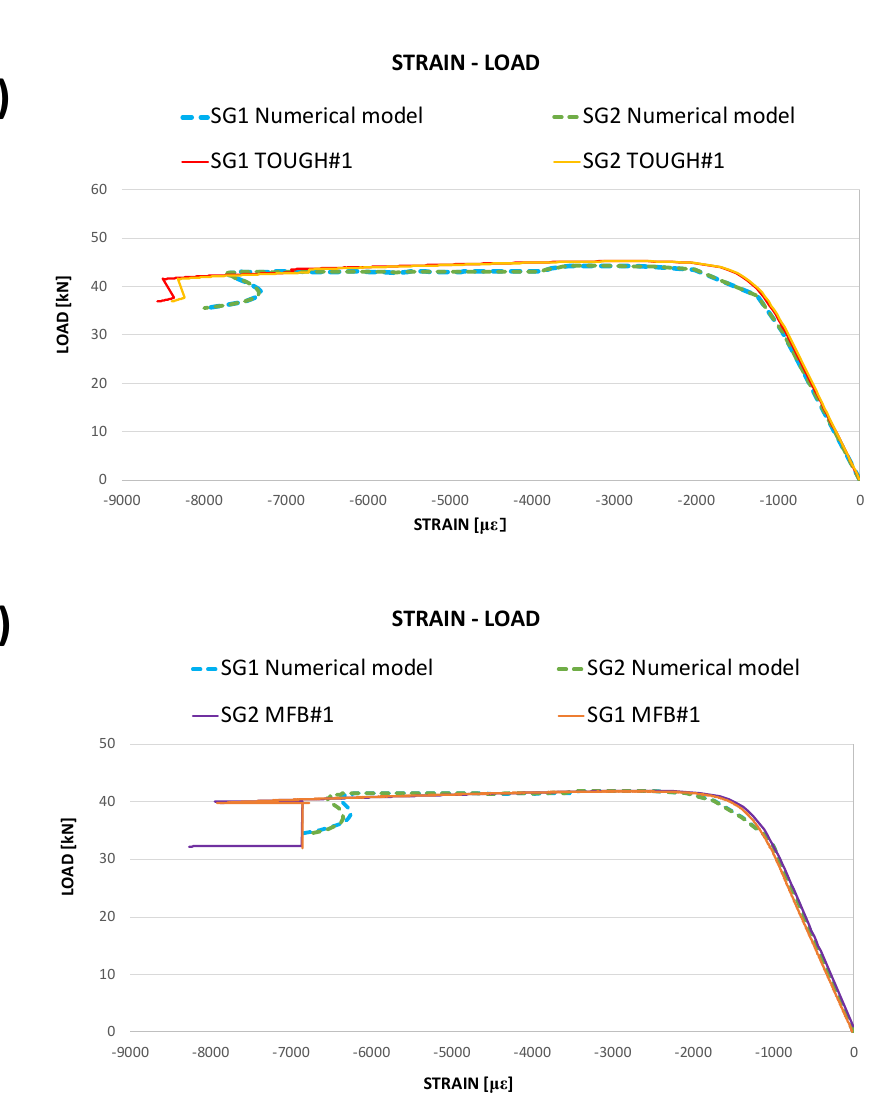
Figure 16. Compressive load as a function of the measured and computed strains in the loading direction: toughened material ( a ) and material sensitive to fibre bridging ( b ).